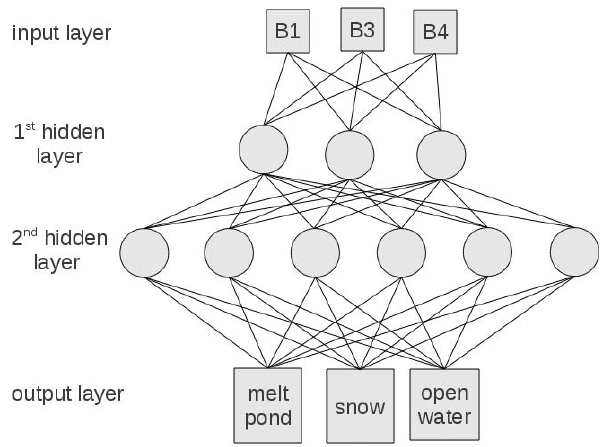
Fig. 3. Architecture of the MLP networks used for this study. The input layer are the MODIS surface reflectances for the three bands 1, 3, and 4. The hidden layers of the MLP used in our study con- tains 9 knots in the first layer and 27 knots in the second layer. For reasons of clarity this Figure shows only 3 knots for the first and 6 knots for the second layer. The output layer contains the three classes melt pond, snow, and open